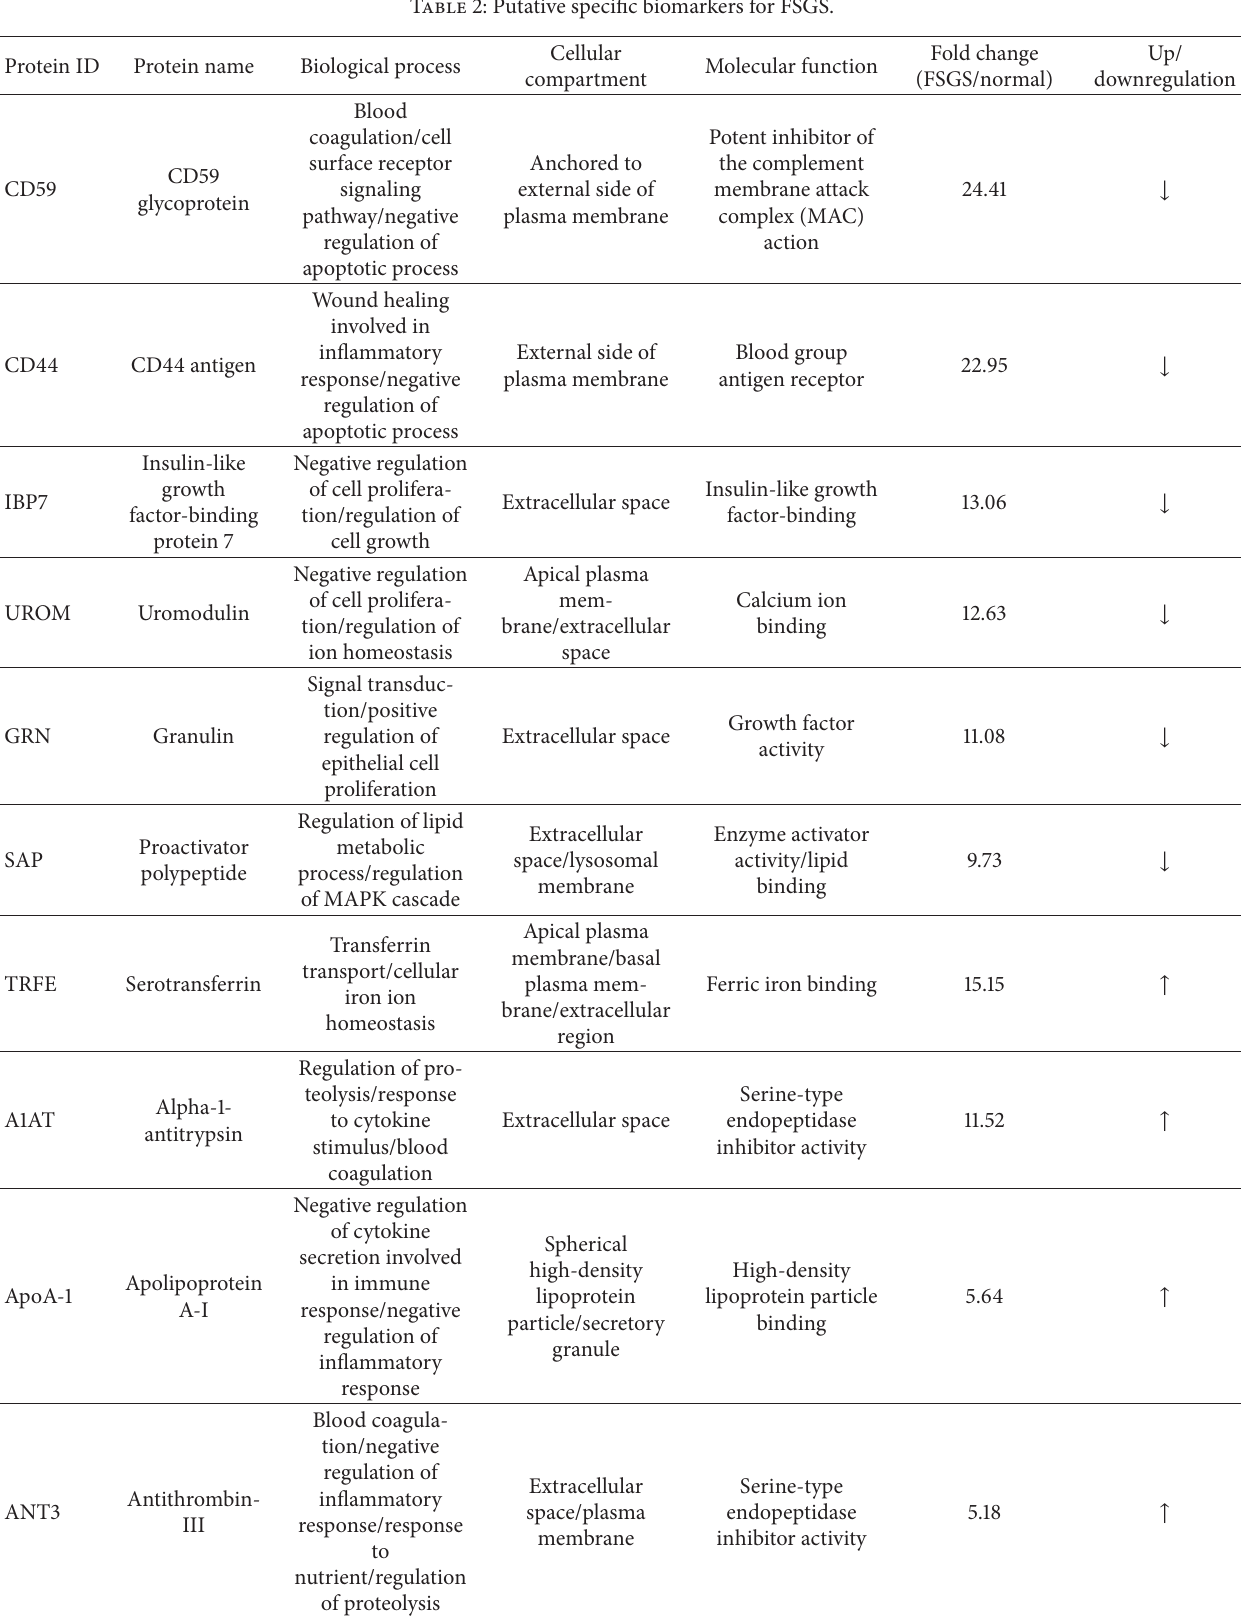
Table 2: Putative specific biomarkers for